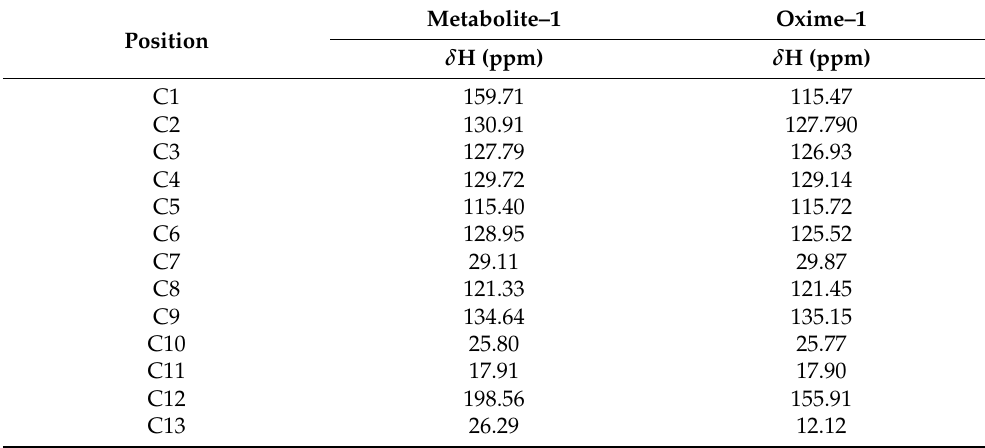
Table 2. 13 C NMR spectroscopic data of metabolite–1 and respective oxime–1 (in CDCl 3 at 150